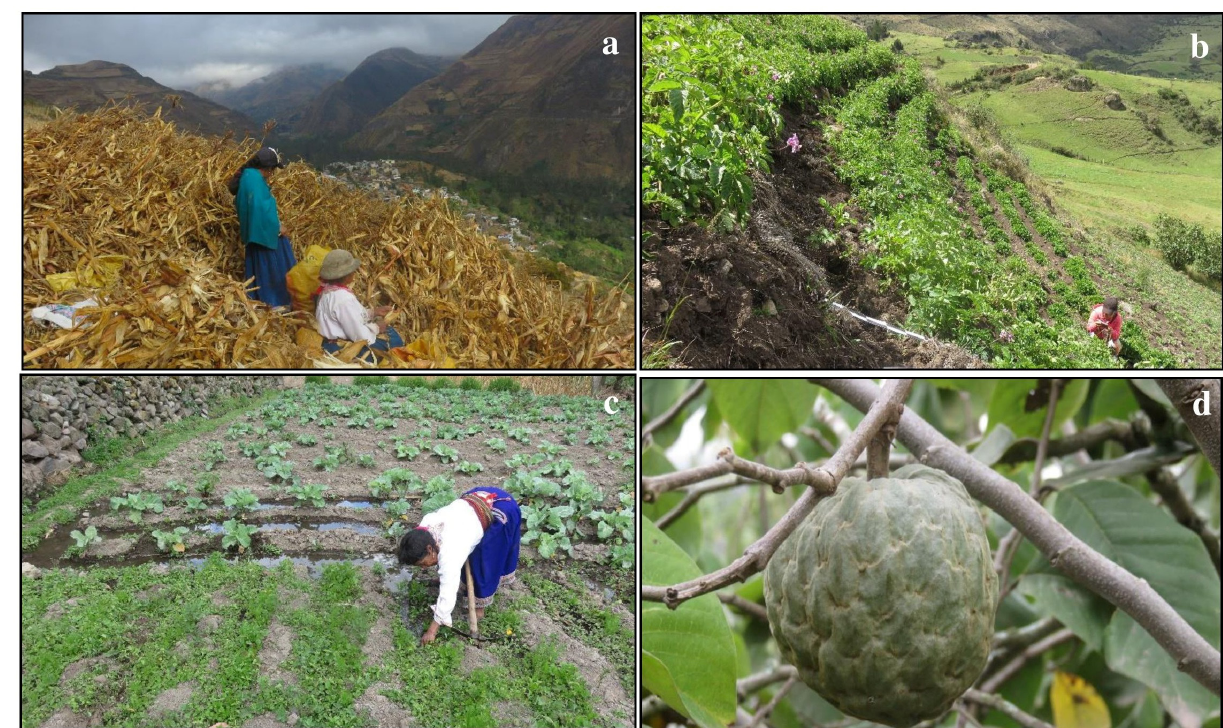
Figure 6. Biodiversity levels of the Nizag community. ( a ) Diversity of landscapes: sub-Páramo, kinray, and pampa zones; ( b ) chacras kinray agroecosystem; ( c ) chacras pampa agroecosystem; ( d ) biological diversity ( Annona cherimola ).